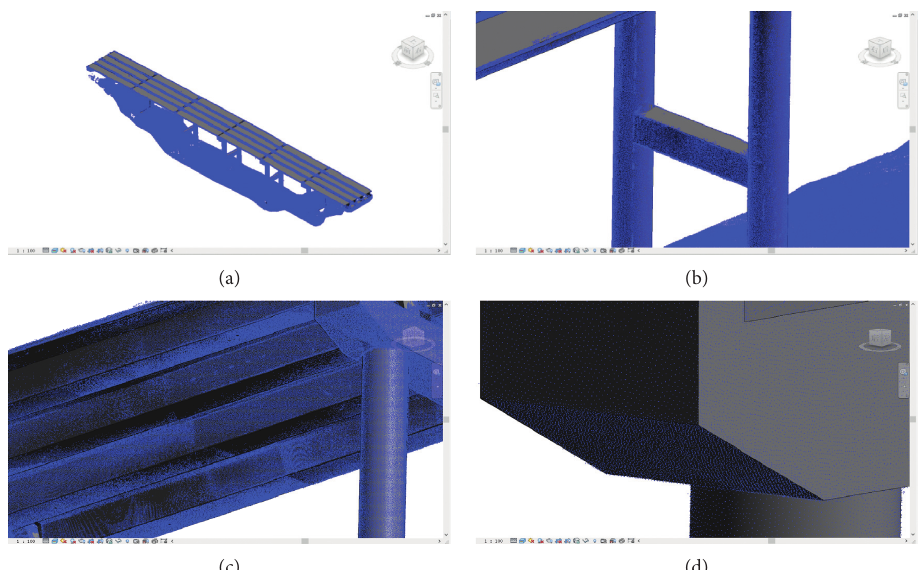
Figure 22: Reconstructed BIM is consistent with its scanned point cloud.